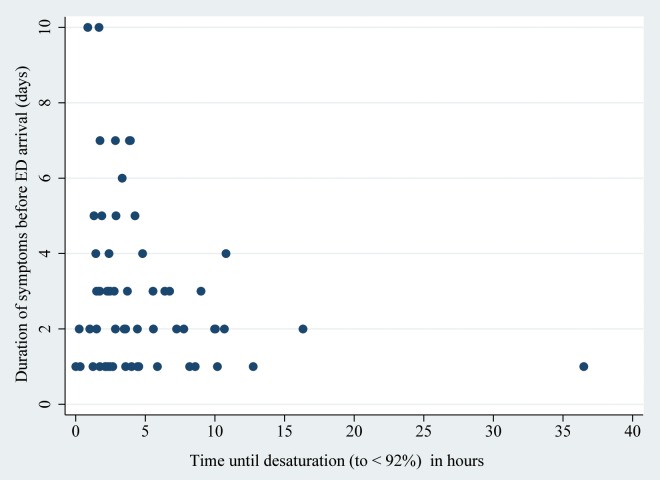
Correlation between duration of symptoms before Emergency Department (ED) arrival and time until desaturation (to < 92%) in patients ≥ 3 months (n = 61).R2 = 0.05, P = 0.08.